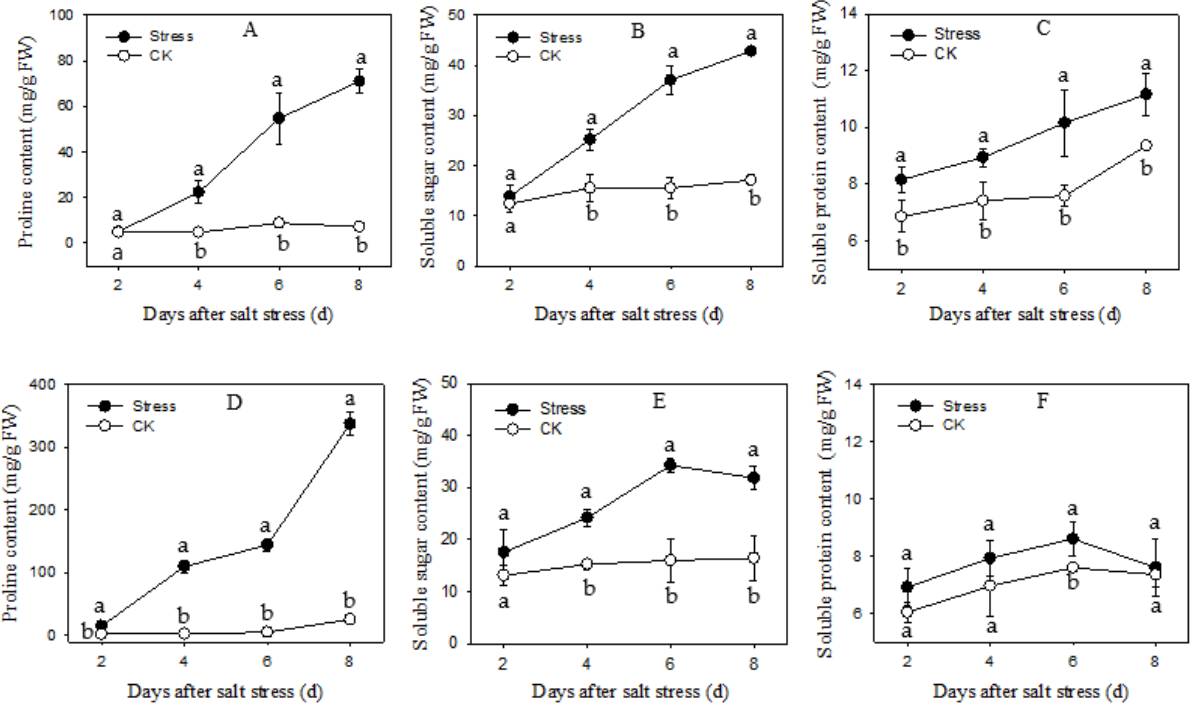
Figure 5. The osmotic regulation substances content of two asparagus cultivars under salt stress.( A – C ) are Apollo and( D – F )are JL 1. Different lowercase letters in the line graph indicate significantly ( A – C ) are Apollo and ( D – F ) are JL 1. Different lowercase letters in the line graph indicate significantly different from the control at p <0.05.CK meaning seedlings were watered by Hoagland solution different from the control at p < 0.05. CK meaning seedlings were watered by Hoagland solution without NaCl, and SS meaning seedlings were subjected tosalt stress of 120 mM NaCl. without NaCl, and SS meaning seedlings were subjected to salt stress of 120 mM